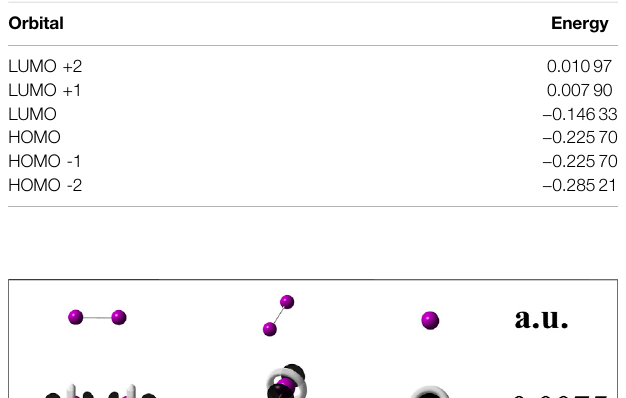
TABLE 3 | Energies (in Hartree) of molecular orbitals in [(C 8 H 11 N 2 )Pt (CH 3 )] at the M06 – L/def2 – QZVPPD level of theory.